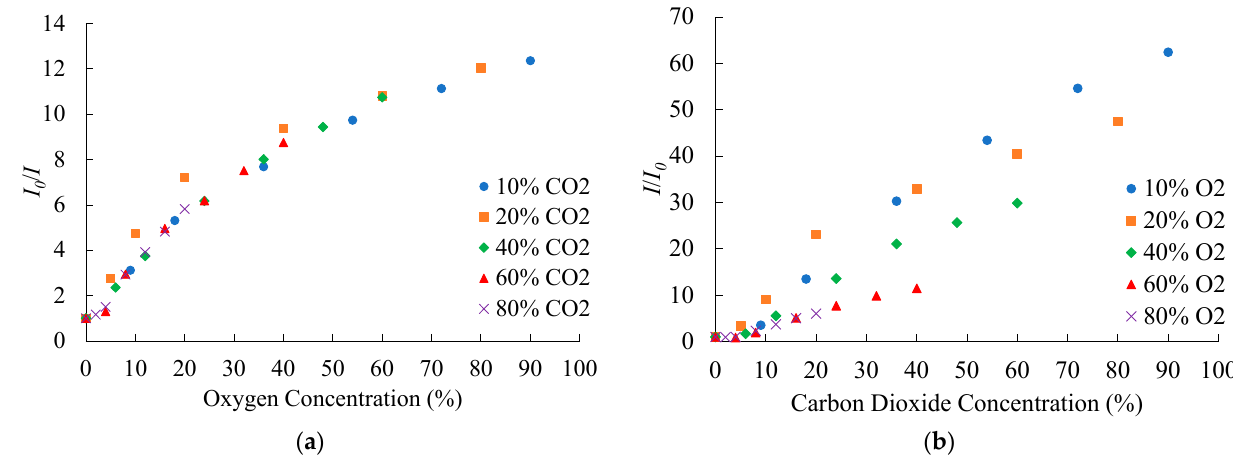
Figure 9. Cross-sensitivity calibration of the dual sensor for ( a ) O 2 and ( b ) CO 2 .